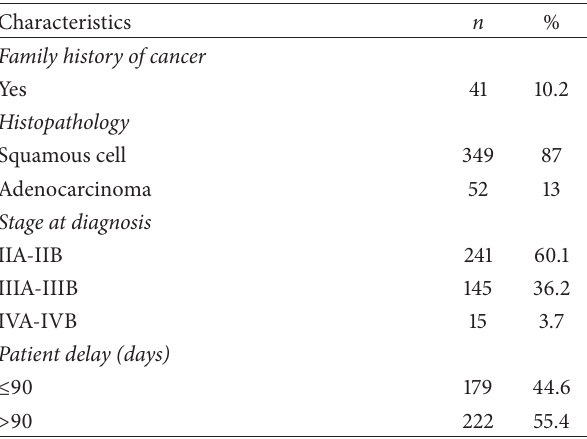
Table 1: Sociodemographic and clinical characteristics of the study population ( 𝑛 = 401